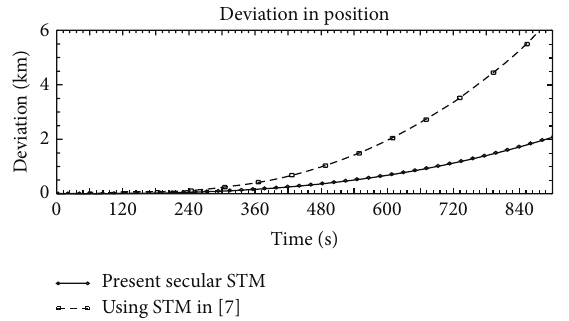
Figure 2: Deviation in position for Molniya orbit.